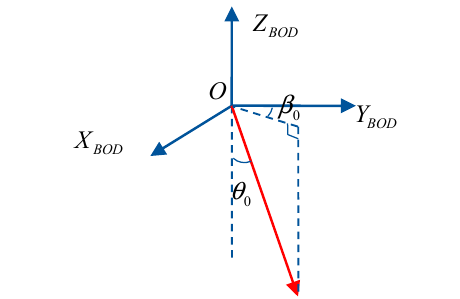
Figure 6. The relationship between the laser boresight vector and the coordinate system of the satellite. θ 0 is the intersection angle between the laser emission direction and − Z BOD direction, β 0 is the intersection angle between the projection direction of the laser boresight on plane ( O − XY ) BOD and the + Y BOD axis. Due to the existence of systemic errors, the estimated footprint geolocation is expressed as Formula (2) [25].